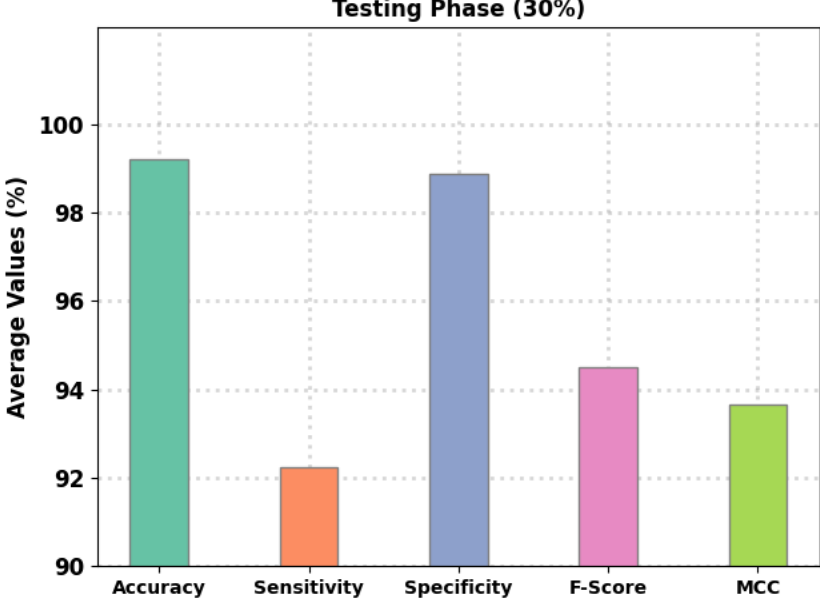
Figure 7. Average analysis of RFER-EADL algorithm under 30% of the TS dataset. Table 4 establishes the overall FER results of the RFER-EADL approach on 20% of TS data and 80% of TR data. Figure 8 shows the FER results of the RFER-EADL technique on 80% of TR data. The effects specify that the RFER-EADL algorithm recognized all facial expressions accurately. For example, for class A, the RFER-EADL methodology provided 𝑎𝑐𝑐𝑢 𝑦 of 99.10%, 𝑠𝑒𝑛𝑠 𝑦 of 89.74%, 𝑠𝑝𝑒𝑐 𝑦 of 99.68%, an 𝐹 𝑠𝑐𝑜𝑟𝑒 of 92.11%, and an MCC of 91.67%. Additionally, for class Di, the RFER-EADL approach provided 𝑎𝑐𝑐𝑢 𝑦 of 98.95%, 𝑠𝑒𝑛𝑠 𝑦 of 91.11%, 𝑠𝑝𝑒𝑐 𝑦 of 99.52%, an 𝐹 𝑠𝑐𝑜𝑟𝑒 of 92.13%, and an MCC of 91.58%. Table 4. Results of the RFER-EADL algorithm for 80:20 of the TR and TS datasets. Labels